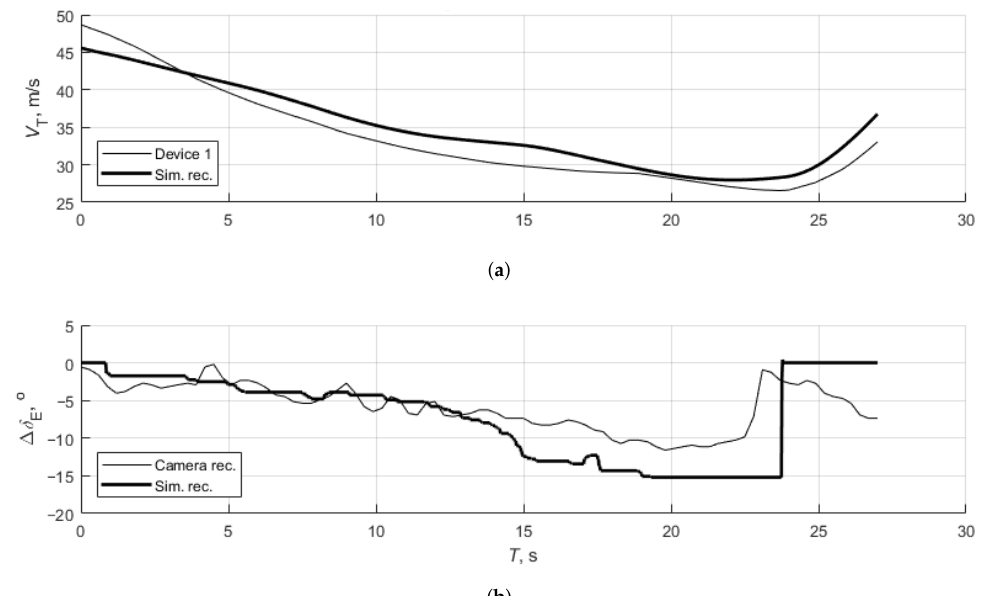
Figure 8. Flight parameters for stall with idle power maneuver from flight simulation “Sim.rec.” and from test flight “Device 1” and “Camera rec.”: ( a ) airspeed V T ; ( b ) elevator deflection angle from trim position ∆ δ E .